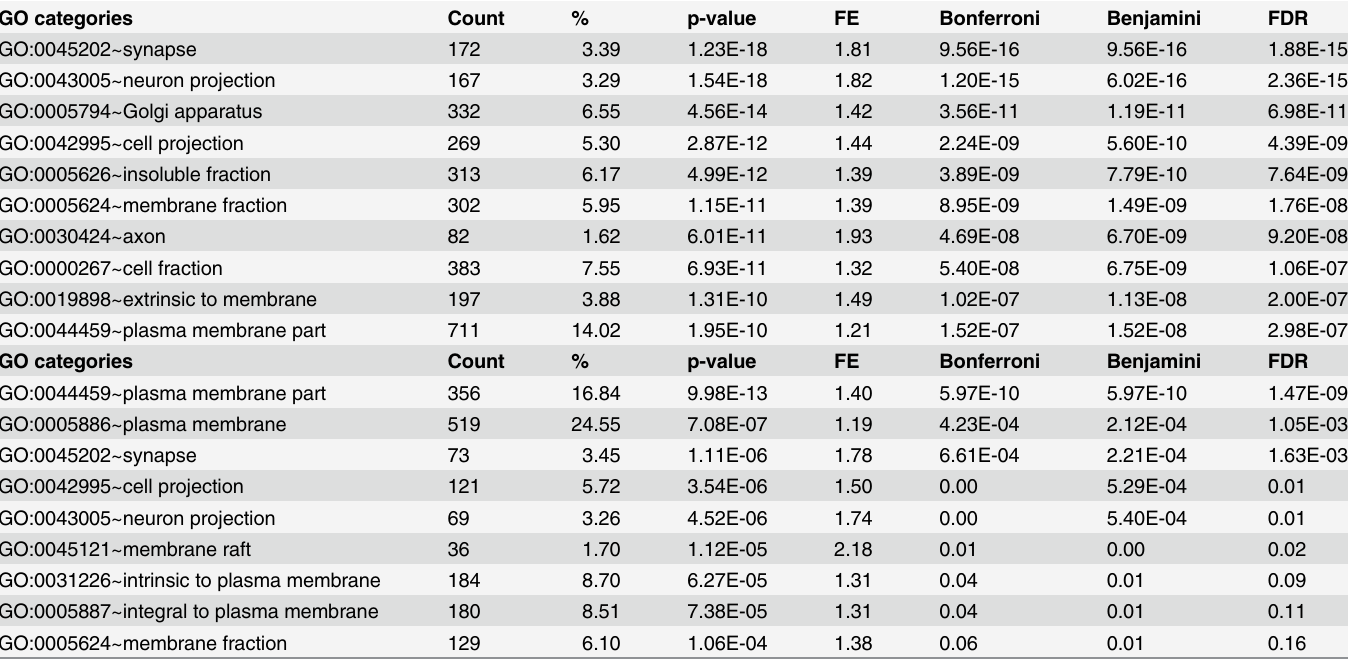
Table 5. DAVID functional annotation; Gene Ontology (GO) categories